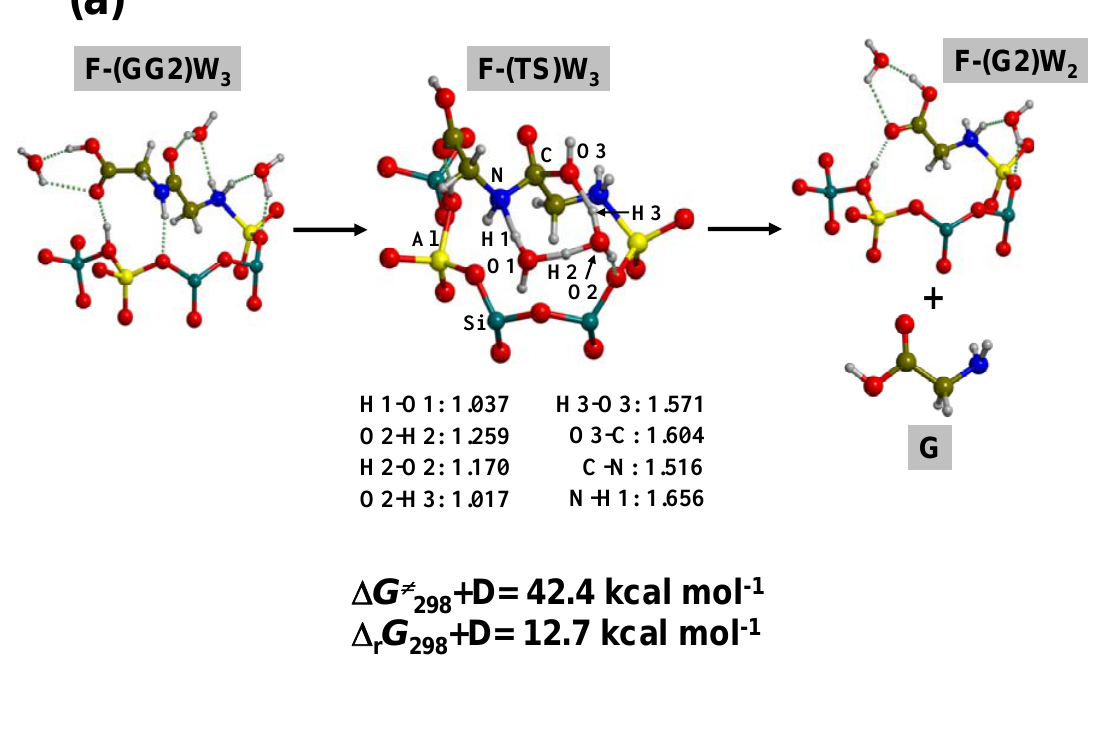
hydrolysis reaction of the GG dipeptide attached to the sanidine feldspar surface in the O molecules. F-(GG2)W presence of three H 2 process of GGG adsorbed at the surface by two H reference